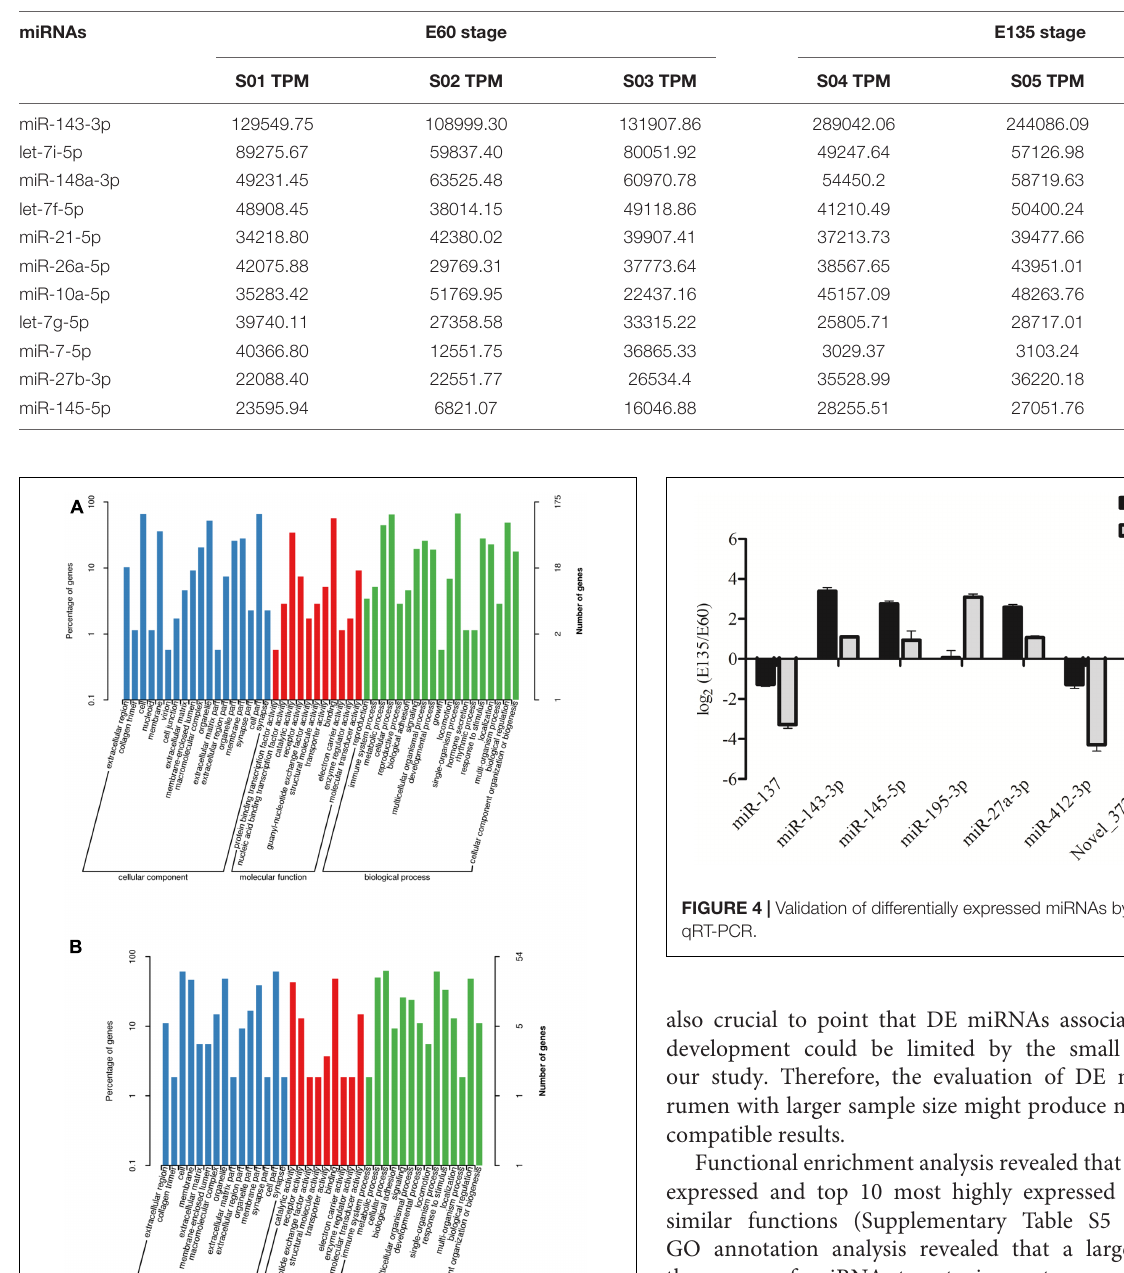
TABLE 3 | Top 10 most highly expressed miRNAs of two libraries.